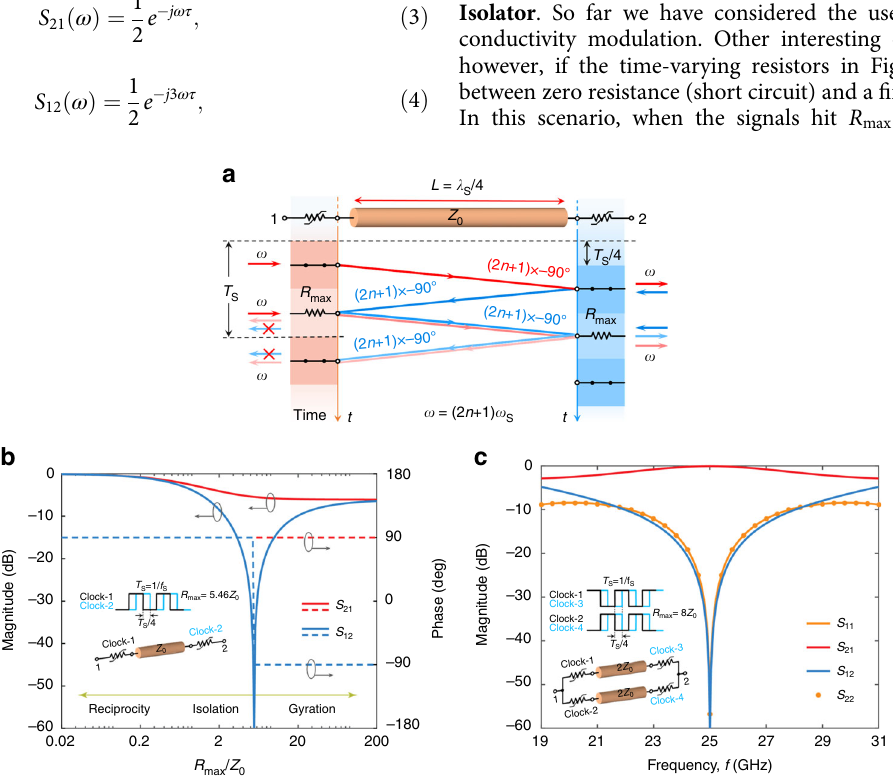
Fig. 2 Isolator based on a delay line with time-varying resistors. a Schematic and operation diagram of the isolator. The circuit is the same as in the case of the non-reciprocal phase shifter, with the only difference that the time-varying resistors are modulated between 0 and a fi nite value R max . b Forward ( S 21 ) and reverse ( S 12 ) transmission versus R max for ω = (2 n + 1) ω s . c Scattering parameters of a double-branch isolator with complementarily clocked switches ( f s = 8.33 GHz), exhibiting ideal transmission, matching and isolation. The transmission line impedance is set to Z = 2 Z 0 and R max ≈ 8 Z 0 . Ideal isolation is achieved at 25 GHz ( n = 1). The inset shows the corresponding network schematic and